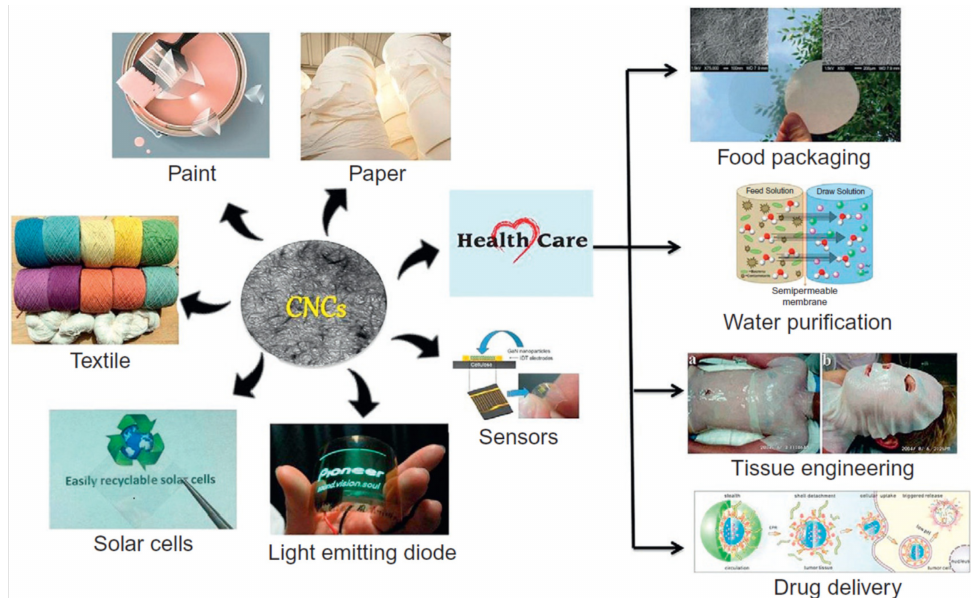
Figure 1. Summarised applications of cellulose-based materials [25]. Copyrights: Elsevier,